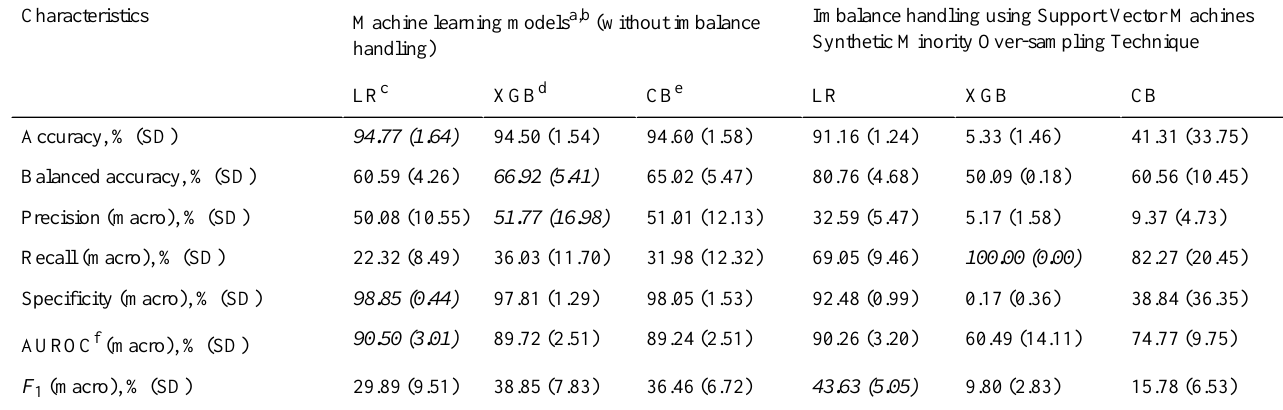
Table 2. Results of the general models for emotional transition detection on the basis of a six-fold, leave-3-people-out cross-validation.